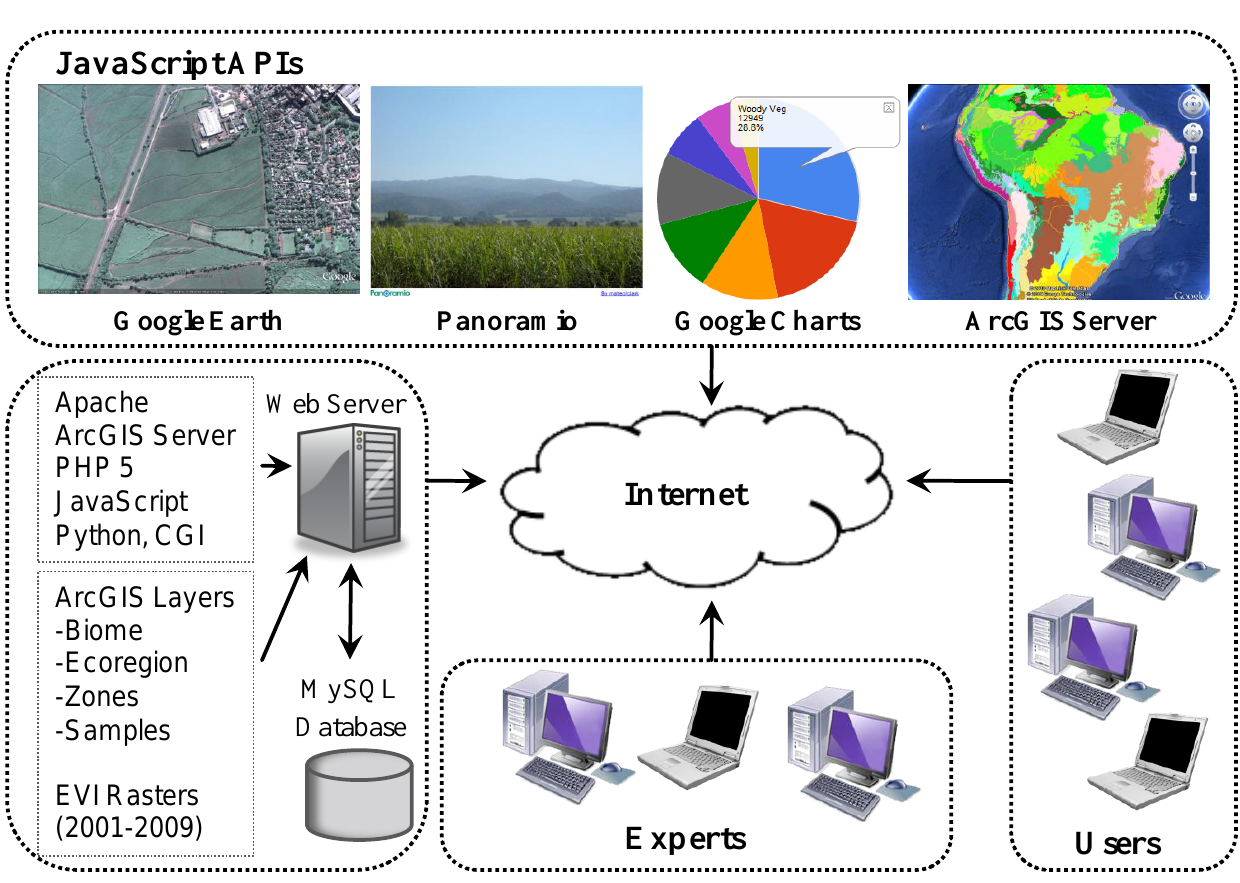
Figure 1. Technical and user components of the Virtual Interpretation of Earth Web-Interface Tool